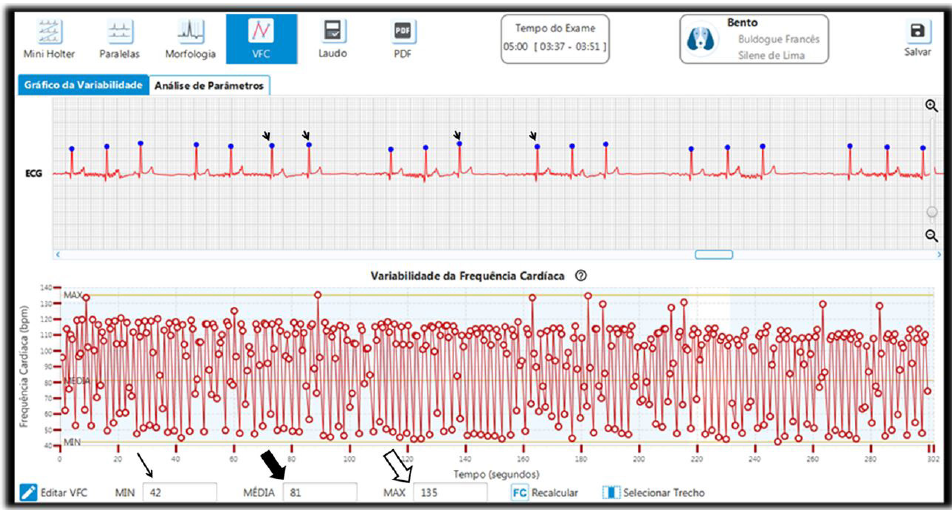
Figure 2. Heart rate variability, showing the R-R (arrowhead), minimum (arrowhead), average (filled arrow), and maximum (arrow) heart intervals (Source: Personal